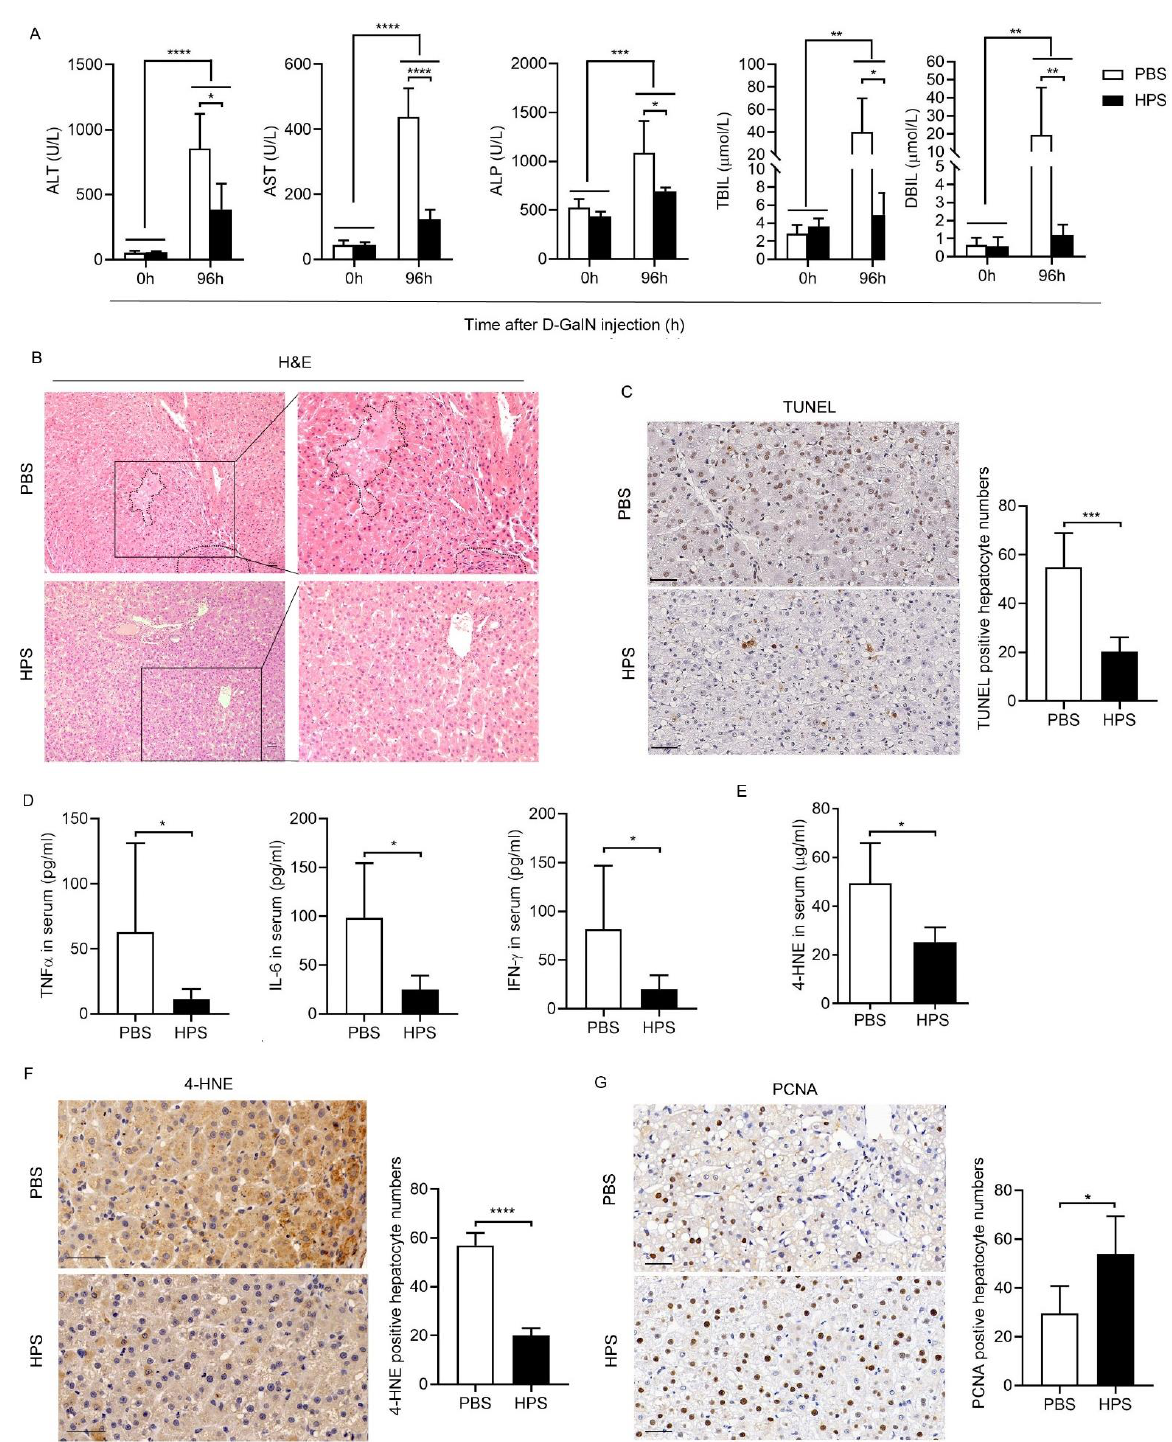
Figure 4. Peripheral delivery of recombinant human HPS prevents acute liver injury in in nonhuman primates. Cynomolgus monkey were injected intravenously with 300 mg/kg D-GalN. HPS (0.25 mg/kg) or PBS were injected intravenously into the monkey at 12 h before and 24, 48, 72 h after D-GalN injection ( n = 5/group). ( A ) Serum ALT, AST, ALP, TBIL, and DBIL levels at 96 h after D-GalN injection were detected. ( B ) Representative images of H&E stained-liver sections of the